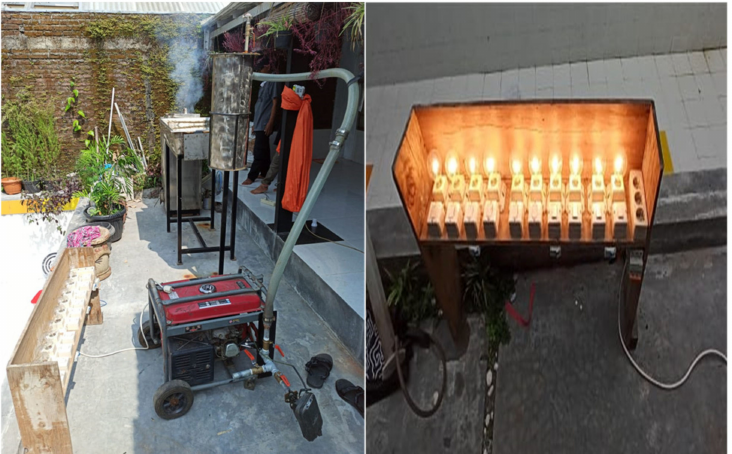
Figure 4. The test is carried out directly by utilizing syngas to operate a generator that is loaded with 20 incandescent light bulbs with a capacity of 50 W